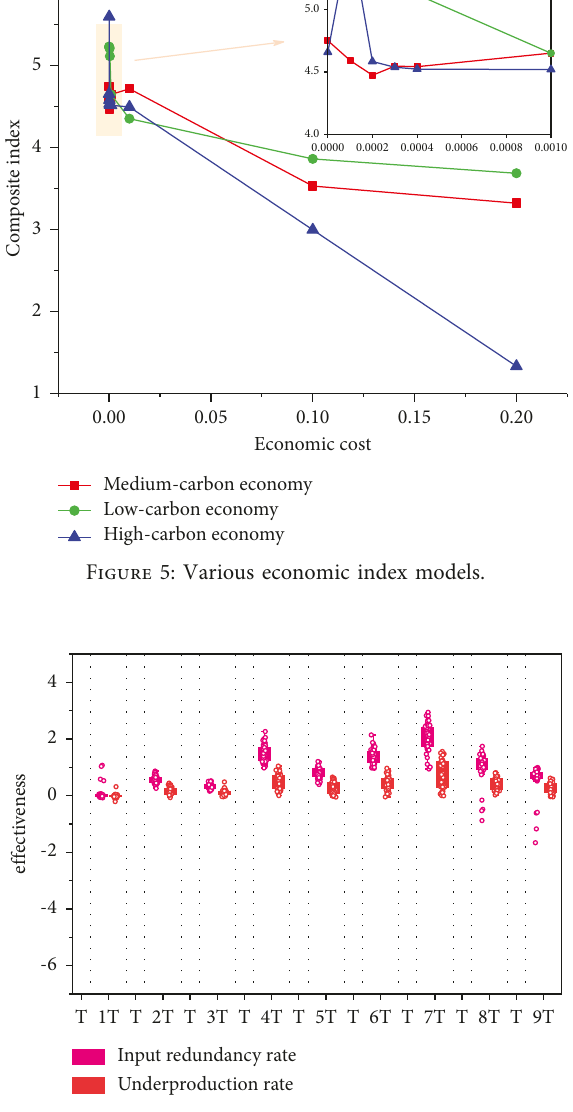
Figure 6: Input redundancy and output insufficient efficiency diagram.